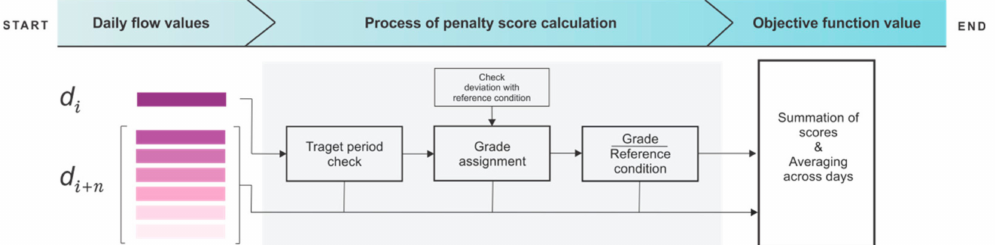
Figure 5. General structure of the calculation process for the penalty score and objective function ( d i and d i + n indicate a day i of the year starting from 1